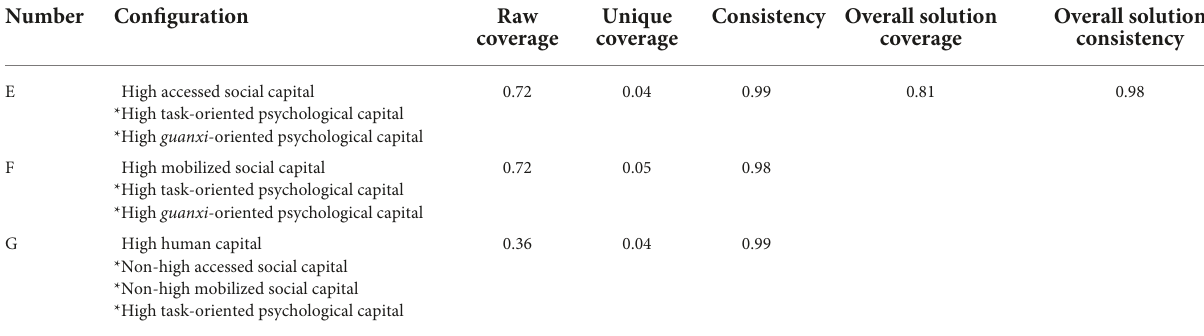
TABLE 4 Configurations for the achievement of high contextual performance.